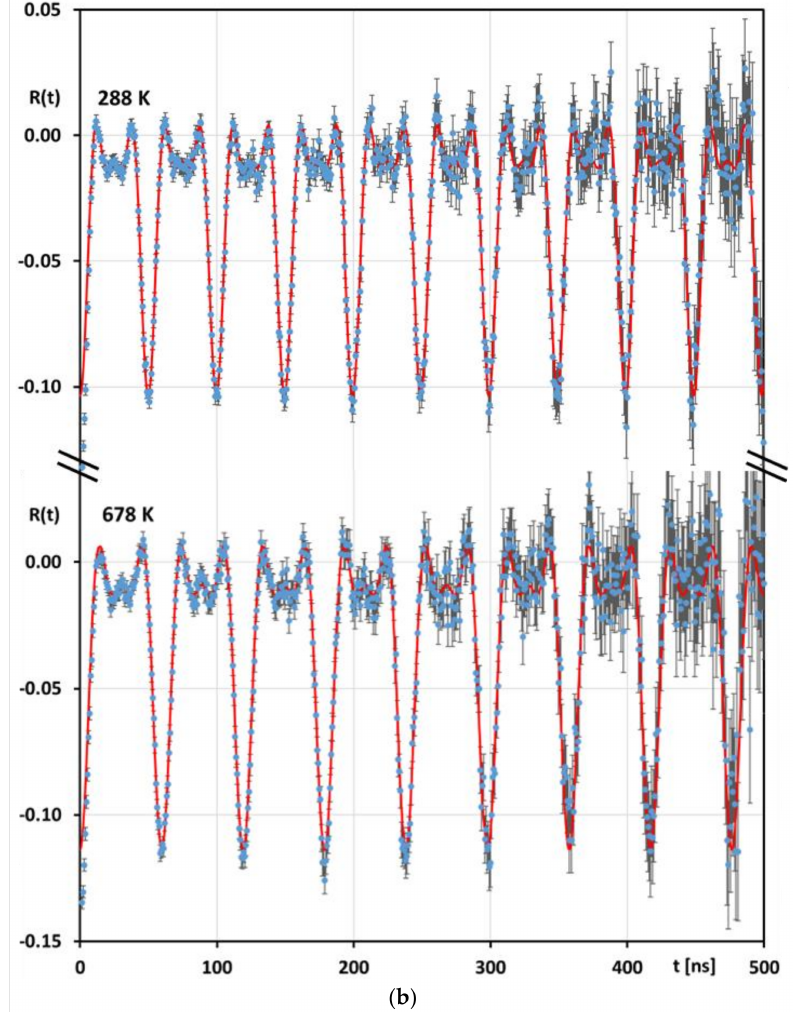
Figure 2. ( a ) Examples for observed PAC spectra taken with the single-crystal sample. The red, solid curves show the least-squares fits that give the quadrupole interaction parameters presented in Table 1. The clear difference between the EFGs is visualized by comparing the spectra obtained at 77 K or 298 K with the spectrum taken at 473 K, and analogous in Figure 2b. ( b ) Examples for observed PAC spectra taken with the polycrystalline sample. The pattern seen is characteristic of a random EFG orientation. Table 1. Nuclear quadrupole coupling constant ν Q measured for 111 Cd (5/2 + ) in a Zn single crystal as function of temperature. The lower four rows present data from the experiments with polycrystalline Zn. Temperature